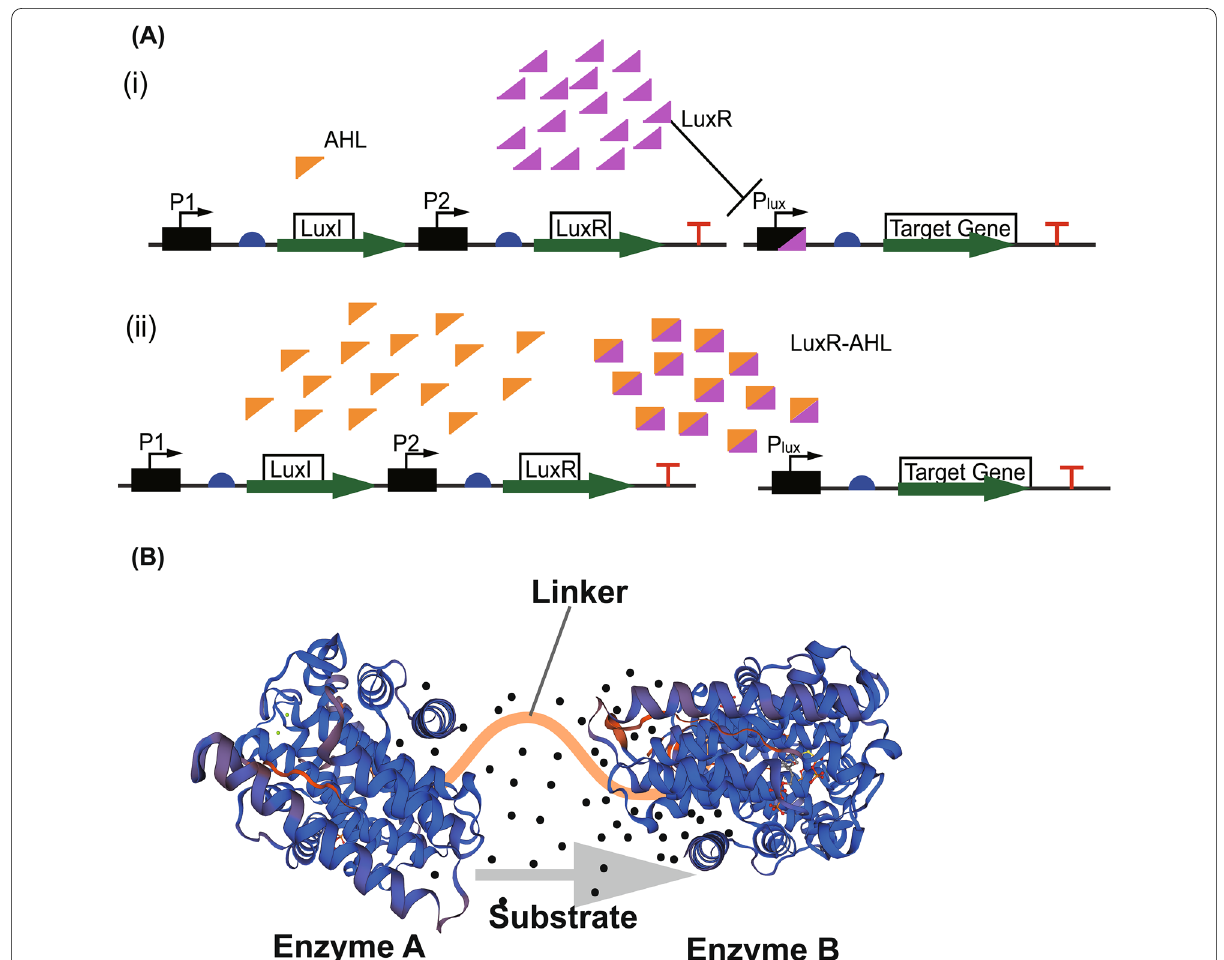
Fig. 3 A Illustration of dynamic control of LuxI/LuxR Quorum Sensing (QS) system. (i) At low cell density, the transcriptional regulator, LuxR, binds the P lux promoter to repress the transcription of the target gene. (ii) At high cell density, LuxI protein synthesizes acyl‑homoserine lactone (AHL) which binds the transcriptional regulator resulting in dissociation from the promoter. The target gene is subsequently expressed. B Graphical representation of putative enzymes joined with a linker. Sequential pathway enzymes can be modified through enzyme fusion to improve enzymatic reaction. The fusion of enzymes ensures substrates are channelled from one active site to the